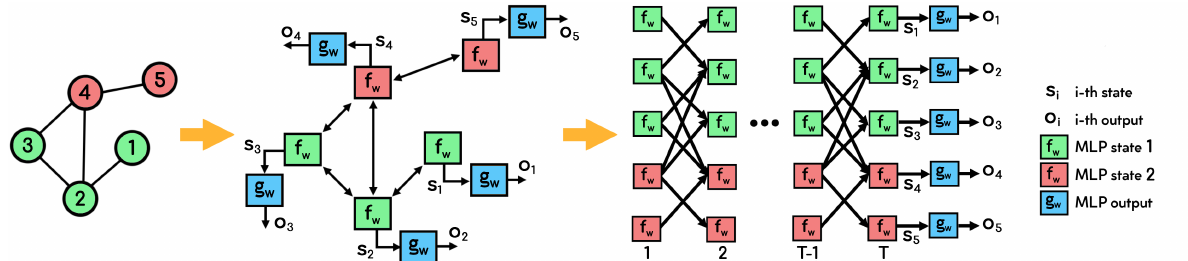
Figure 1. Scheme of a CGNN learning process on a heterogeneous graph. From the left: The input heterogeneous input graph, where blue and red circles represent two types of nodes, and connections belong to a single undirected edge type. The encoding network, generated by means of the MLPs implementing the state transition functions f w (red and green rectangles, one for each node type) and the output function g w (blue rectangles). The unfolding network, in which the information can flow from the input to the output, passing through the aformentioned MLPs and the graph connections defining this feed-forward neural network. Note that for a non-composite GNN, learning on a homogeneous graph, the scheme is the same, with the only MLP state 1 considered in this setting, since only one type of node is admitted. This figure was taken from